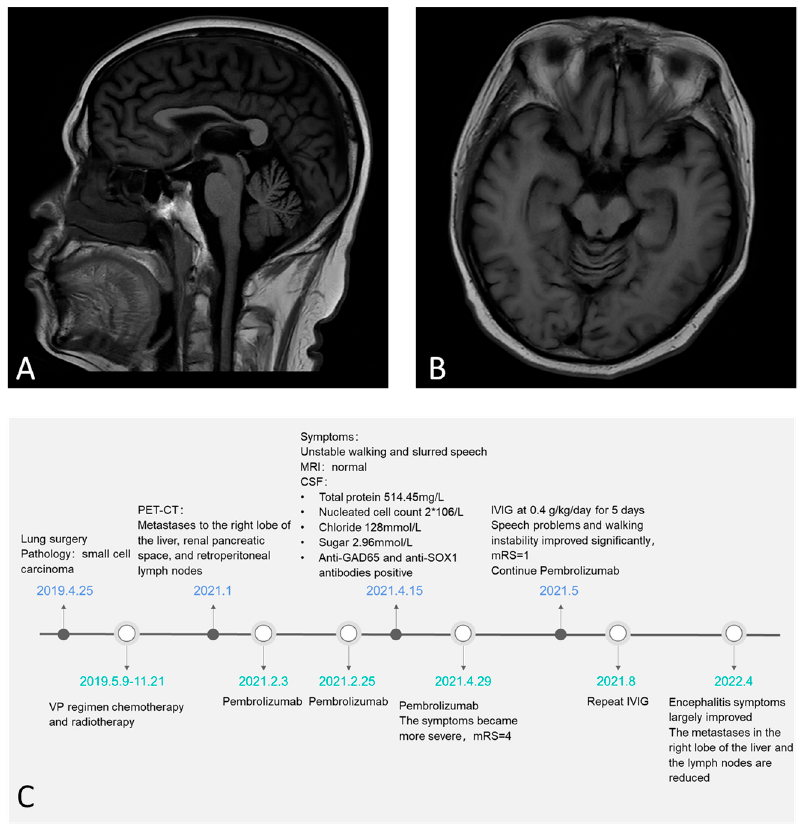
Figure 1. Mild cerebella atrophy evidence on sagittal and axial brain MRI ( A , B ). The timeline of the patient ( C ).